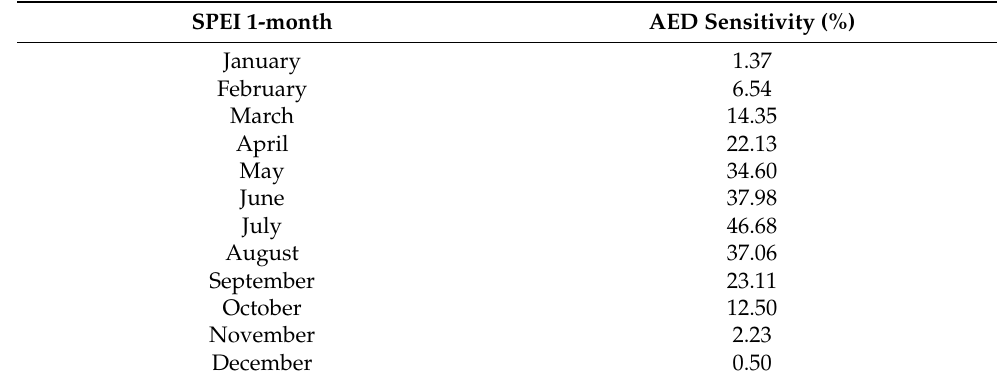
Table 1. Sensitivity of the SPEI to atmospheric evaporative demand (AED) on mainland Spain and the Balearic Islands over the period 1961–2018 at a short time scale (1-month). The monthly series include the weekly data for the last week of each month in each